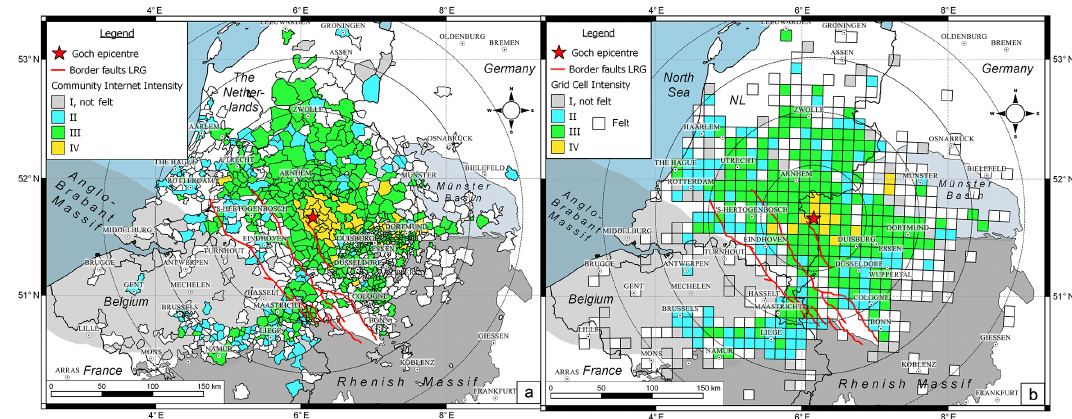
Figure 6. 2011 Goch earthquake intensity maps. (a) ZIP-CIIM using all 9087 entries (no NRW-GD). (b) Merged grid cell intensity map gen- erated with only geocoded responses from ROB-BNS, KNMI, and intensity data from EMSC and USGS. Note the absence of macroseismic entries in northeast Belgium. Grid cell size is 100km 2 . Circles represent 50, 100, 150 and 200km epicentral